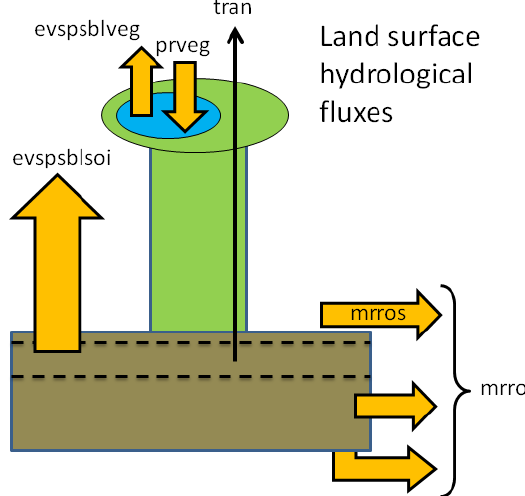
Figure 10. Requested land surface hydrological flux